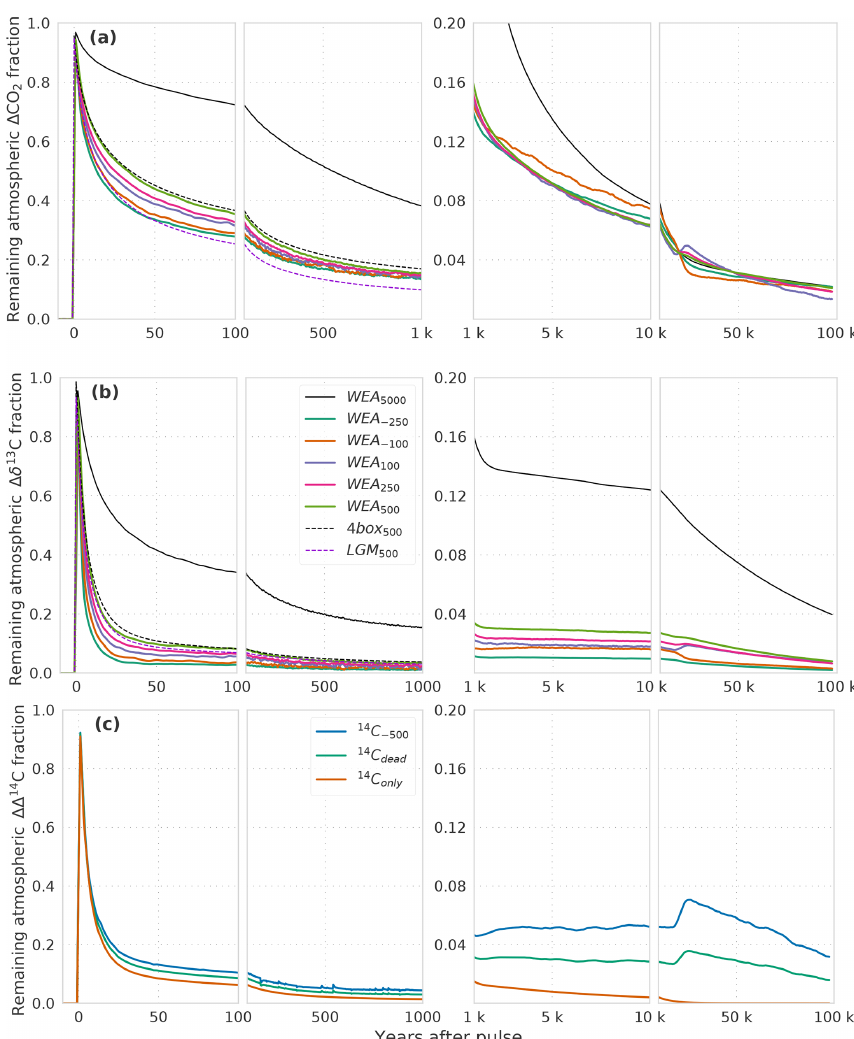
Figure 1. (a) CO 2 , (b) δ 13 C, and (c) (cid:49) 14 C perturbations in the atmosphere for different simulations with different pulse sizes and model configurations. The isotopic signature is δ 13 C =− 24‰ for all pulse sizes except the 5000GtC pulse with δ 13 C =− 28‰. See Table 1 and Sect. 2.2 for details of the experimental setup of the runs. Data are filtered with a moving average of 1000 years in the interval 1–10kyr and 5000 years in the interval 10–100kyr for better visibility. Factorial simulations (WEA 500 , SED 500 , CLO 500 , 4box 500 , and LGM 500 ) for the time interval 1 to 100kyr are shown in Fig. 2 for better